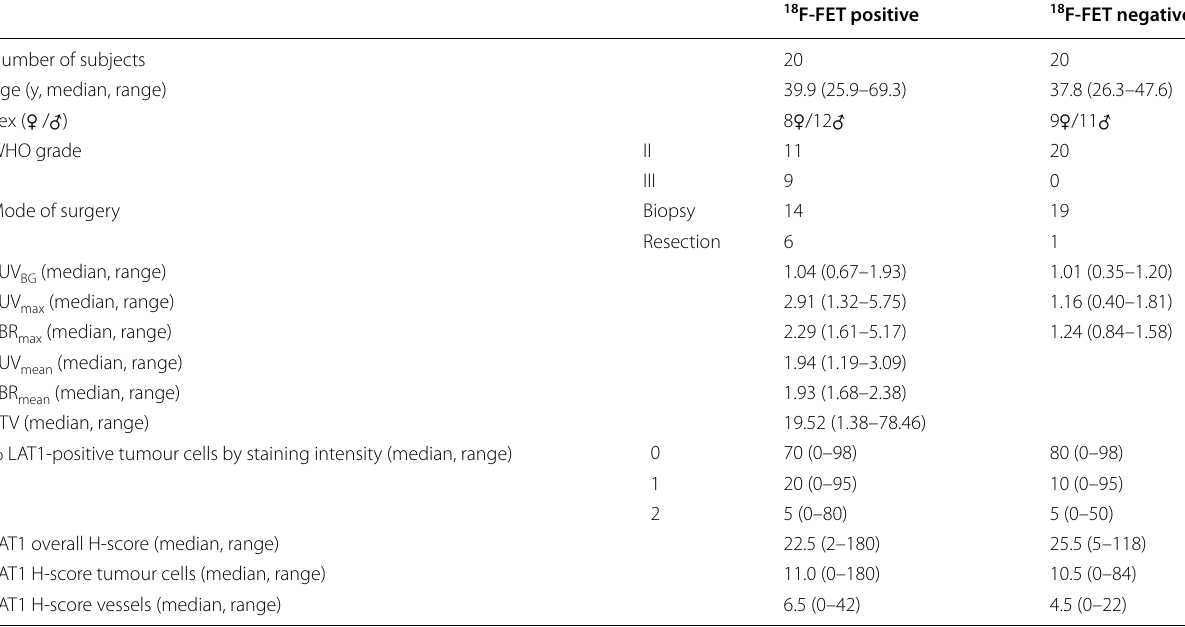
curve. The median TTP min in the 18 F-FET-positive group